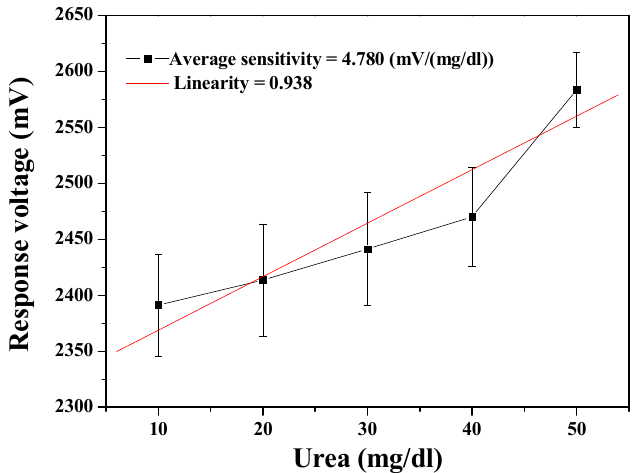
Figure 6. Responses of the urea biosensor based on MBs-urease / GO / NiO by integrating the wireless measurement system.